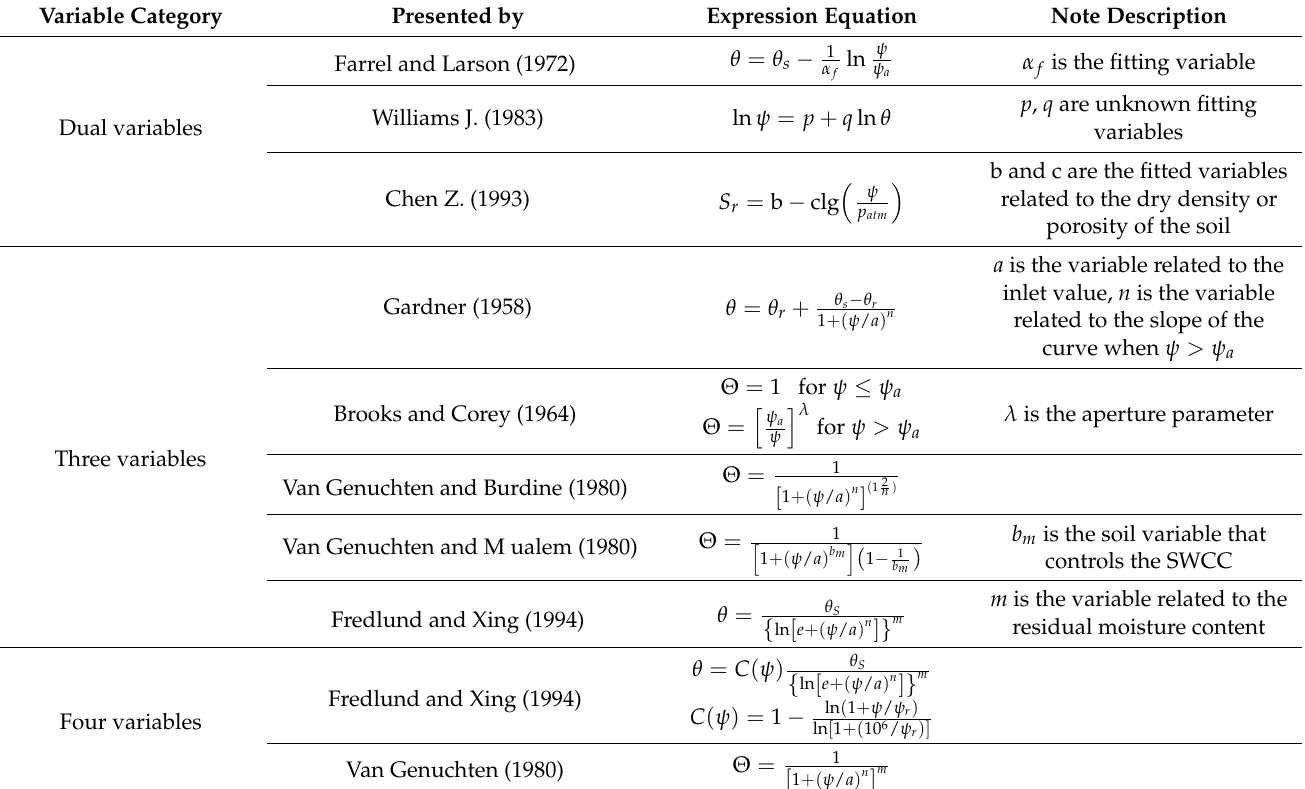
Table 4. Equation to express the soil–water characteristic curve